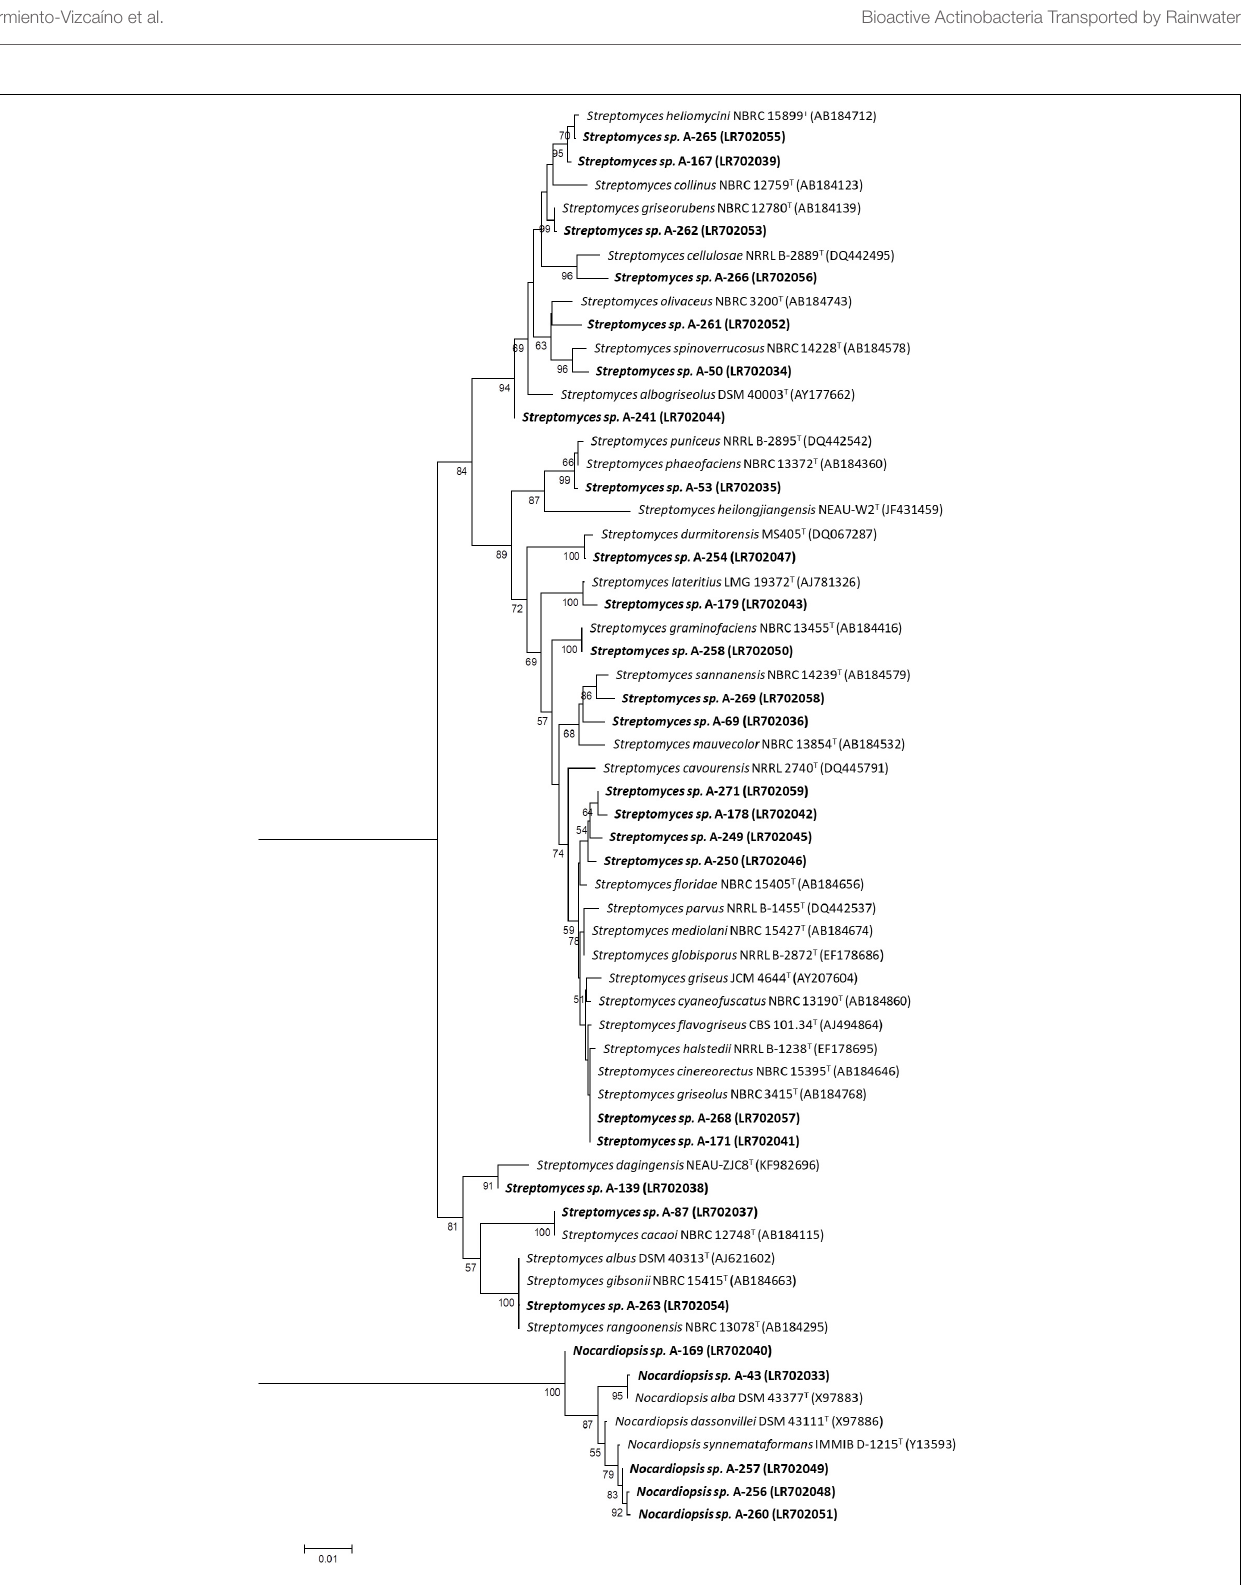
FIGURE 4 | Neighbor-joining phylogenetic tree generated by distance matrix analysis of 16S rRNA gene sequences from atmospheric Actinobacteria ( Streptomyces and Nocardiopsis ) strains (highlighted) and nearest phylogenetic relatives. The numbers on branch nodes indicate bootstrap values (1,000 resamplings; only values > 50% are shown). Bar represents1% sequence